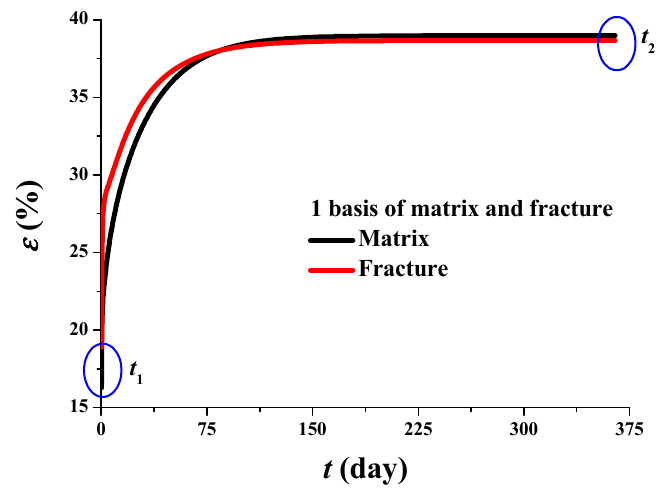
Figure 3. Numerical errors of pressures in the matrix and fracture for typical POD modeling.